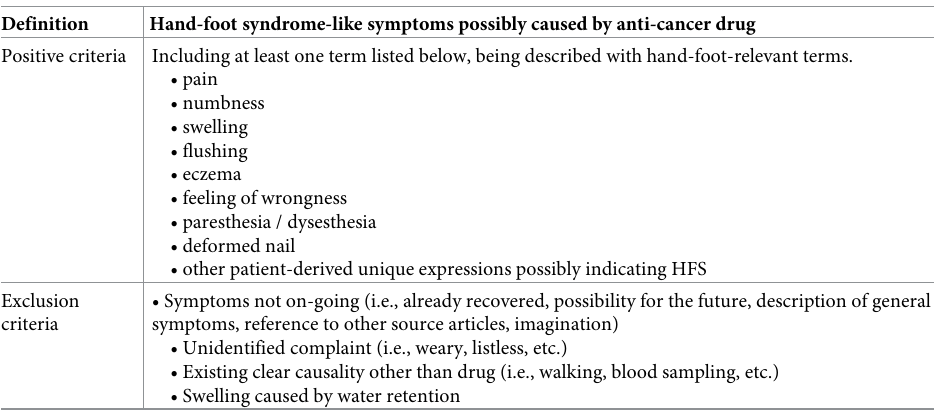
Table 1. Annotation